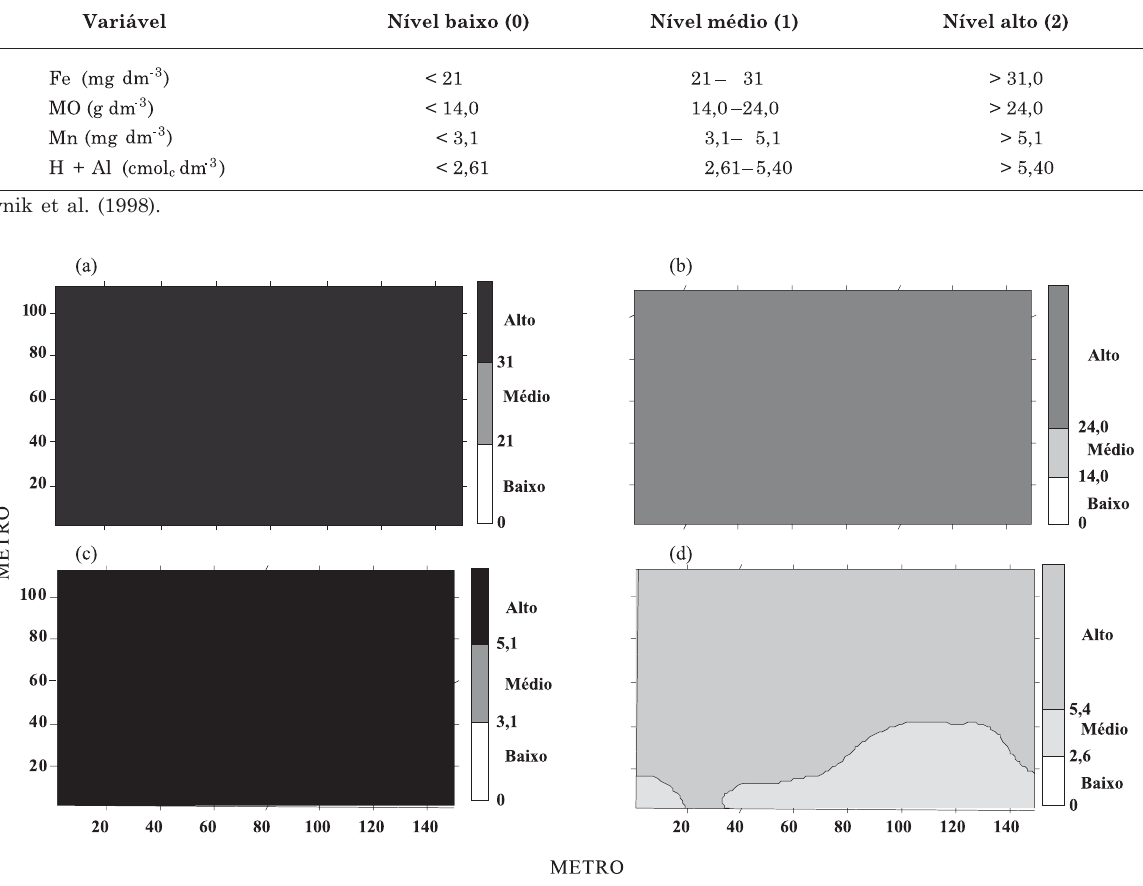
Figura 8. Mapas de variabilidade das variáveis Fe (mg dm -3 ) (a), MO (g dm -3 ) (b), Mn (mg dm -3 ) (c) e H + Al (cmol dm -3 ) (d), de acordo com a classificação da EMATER-PARANÁ (Oleynik et al., c